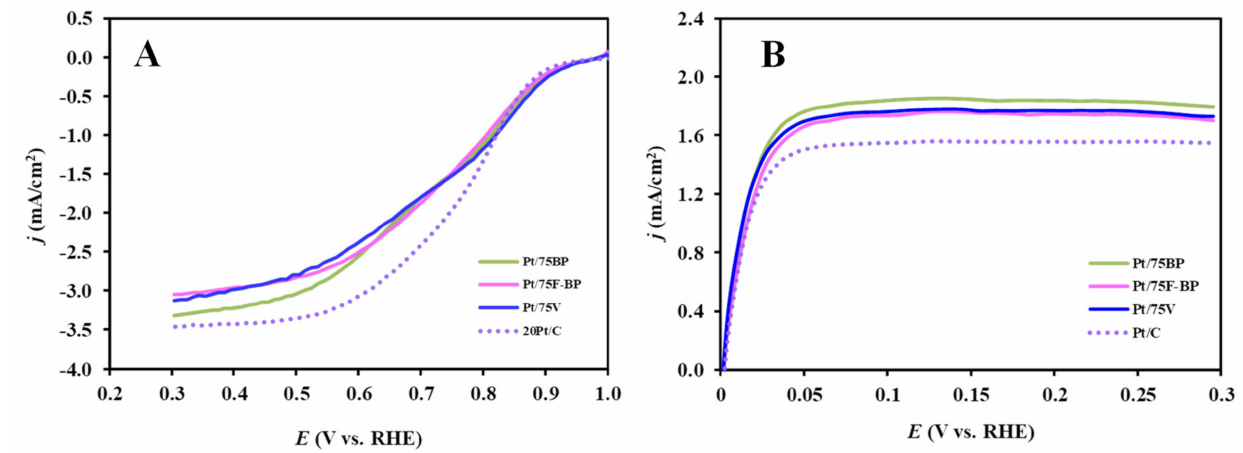
Figure 6. Electrochemical characterization of the reference Pt/C (dotted violet) and Mo-containing composite-supported Pt catalysts by RDE measurements at 900 rpm: Pt/75BP (green), Pt/75F-BP (pink), and Pt/75V (dark blue). ( A ) ORR curves obtained in O 2 -saturated 0.5 M H 2 SO 4 ; ( B ) HOR curves obtained in a H 2 -saturated 0.5 M H 2 SO 4 . Obtained at 10 mV s − 1 , T = 25 ◦